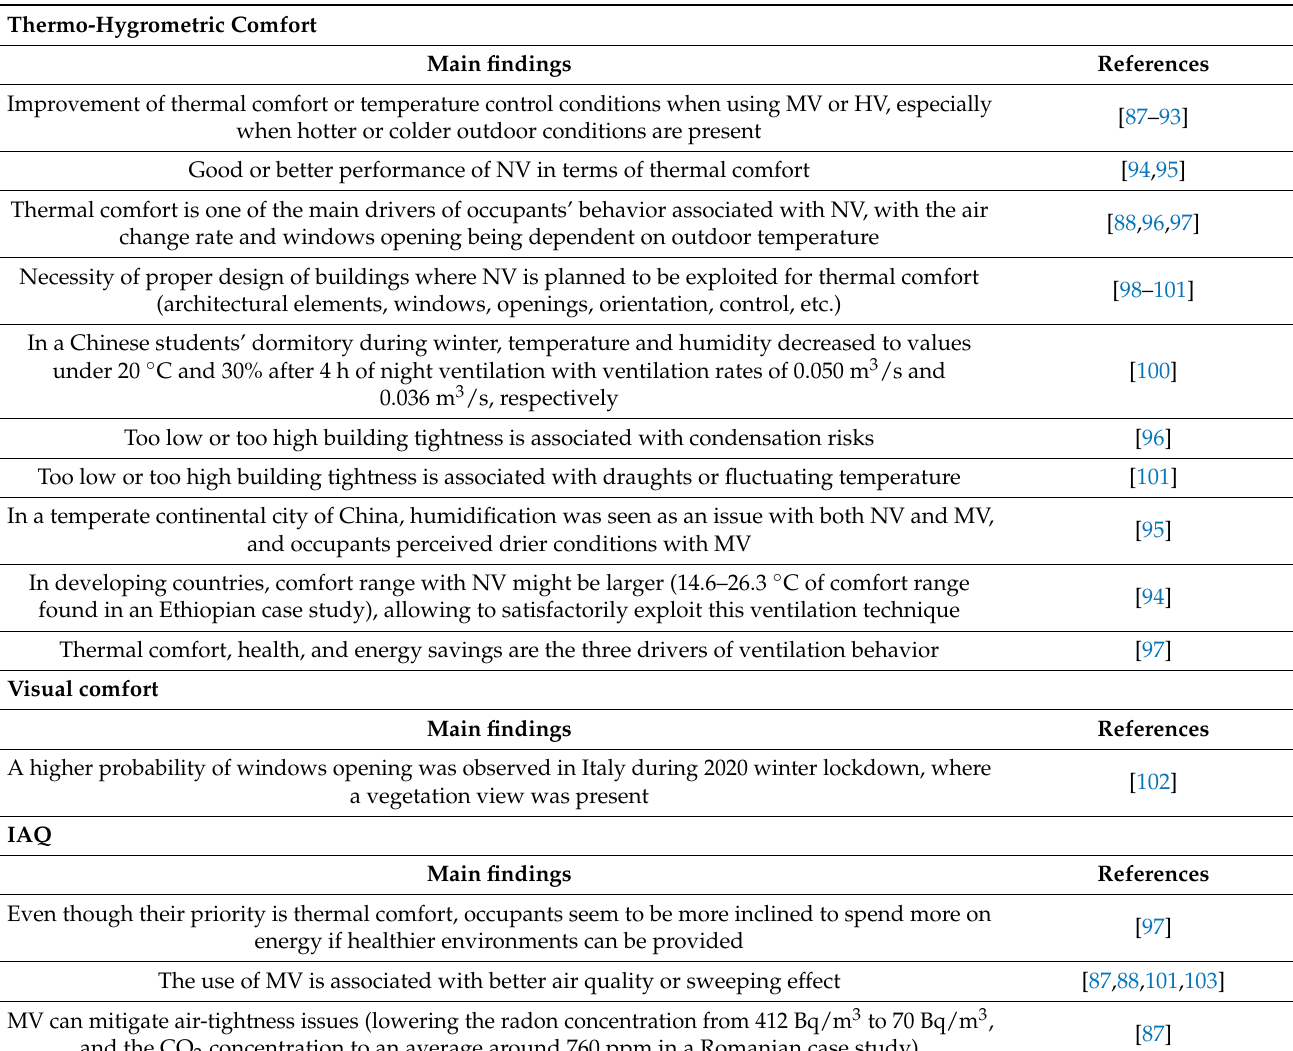
Table 1. Key findings related with residential